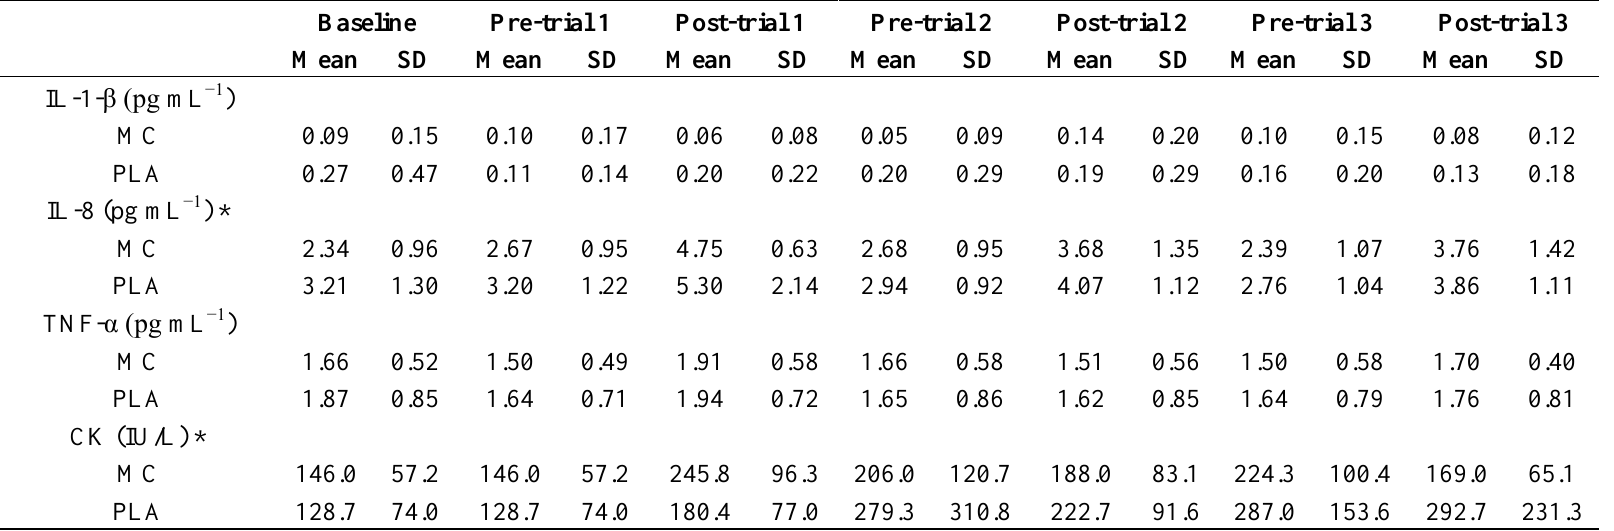
Table 2. Markers of inflammation and muscle damage not different between